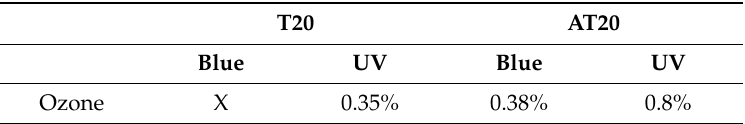
Figure 6. ( a ) The resistance–time relation of films at an ozone concentration of 100 ppb under different light irradiation. ( b ) Differential curves under light irradiation. Table 2. The sensitivity ((R g − R a ) / R a ) of gas ozone for 300 s gas exposure.